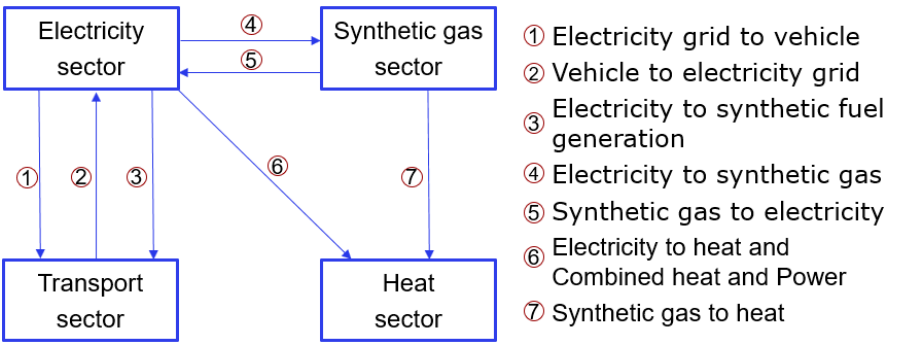
Figure 2. Potential synergies across the modeled sectors. Figure taken from